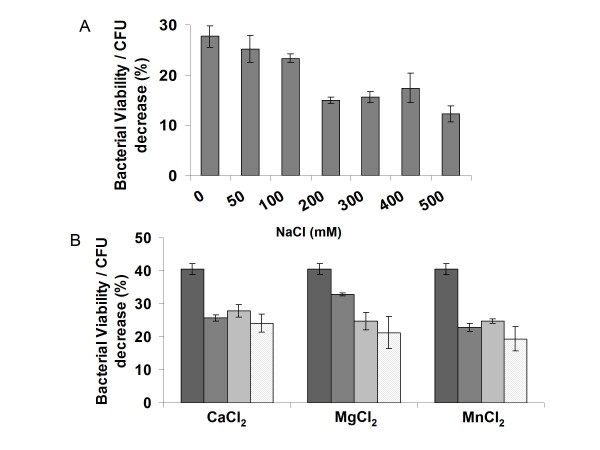
Effect of NaCl and divalent cations on the antimicrobial activity of HydH5. A) Activity was determined in 50 mM phosphate buffer containing different NaCl ionic strength. B) Activity was determined in the presence of different concentrations of CaCl2, MgCl2, and MnCl2( 0 mM,  0.75 mM,  1.25 mM,  10.25 mM). Error bars are the means ± standard deviations of three independent assays.